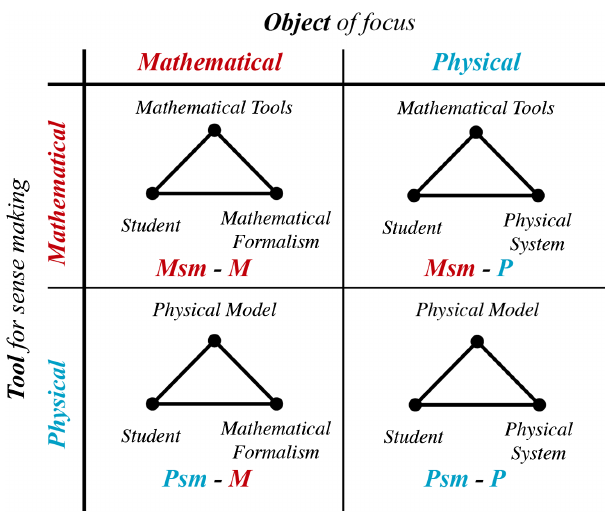
FIG. 2. The four reasoning structures (modes) of the categorical sense making framework. These modes differ based on the object of the sense making and the tool employed in the sense making.